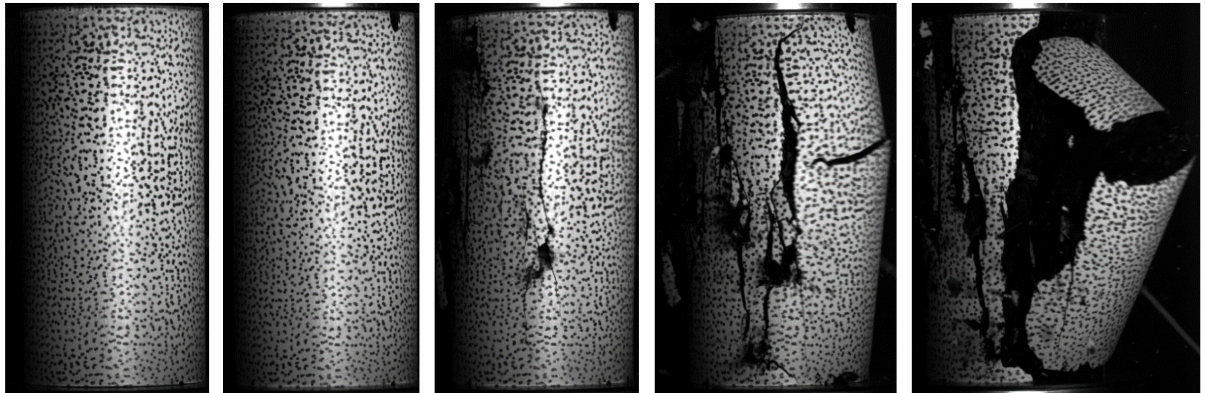
Figure 5. The failure process of specimen P4.